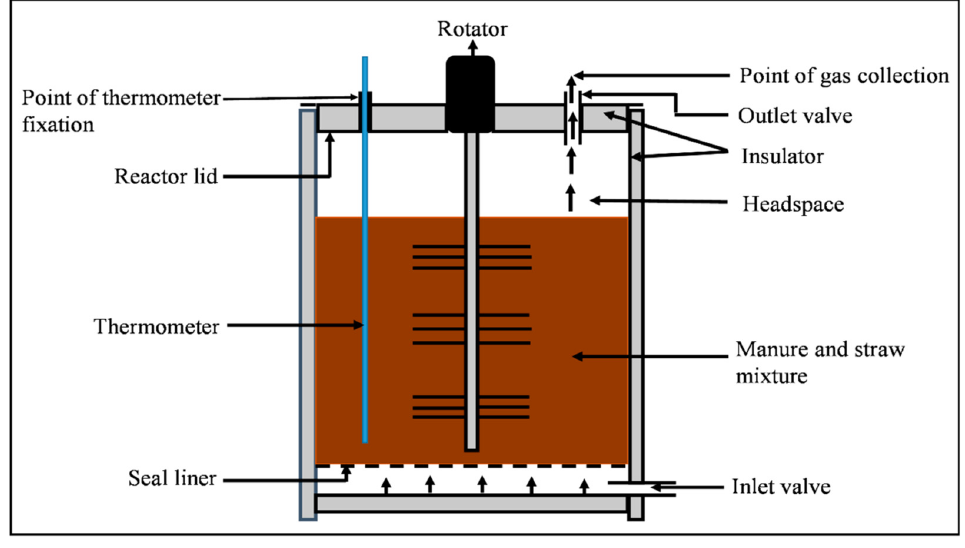
Figure 1. Schematic diagram of the composting